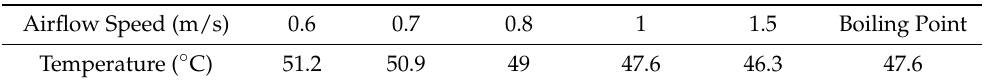
Table 4. Temperature at the outlet of the stator model for CCSSECAC when the temperature rise was 50 °C.